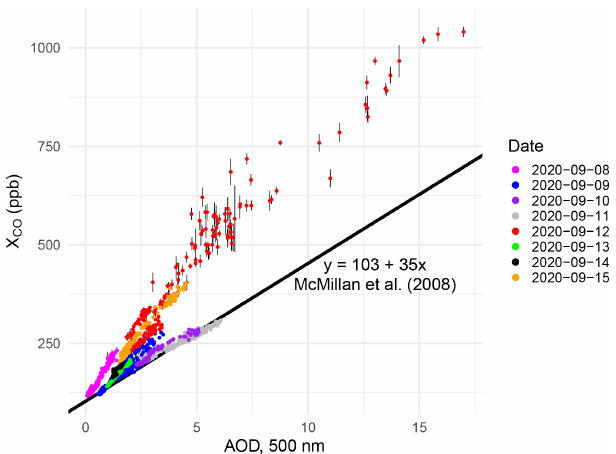
Figure 3. Scatterplot correlations of X CO and AOD at 500nm from the FTIR for each day from 8–15 September 2020. Some days fall along the gray line that was derived from previous remotely sensed X CO to AOD relationships over a clean region. The red markers correspond to 12 September, the day of highest fire influence in our